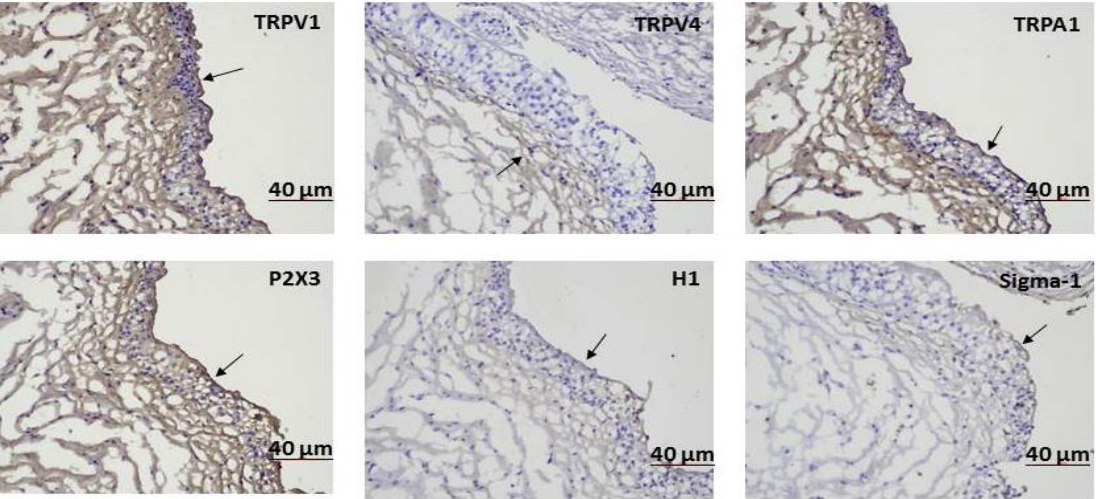
Figure 1. Immunohistochemistry staining of sensory receptors in the bladder urothelium of patients with interstitial cystitis/bladder pain syndrome. Arrows indicate the expression of these sensory receptors in the bladder urothelium.